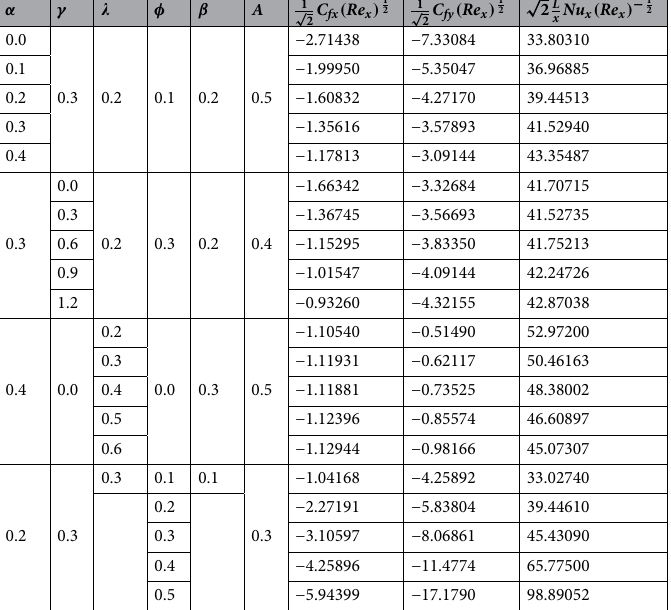
Table 4. Variation of Distinct Parameters on Skin